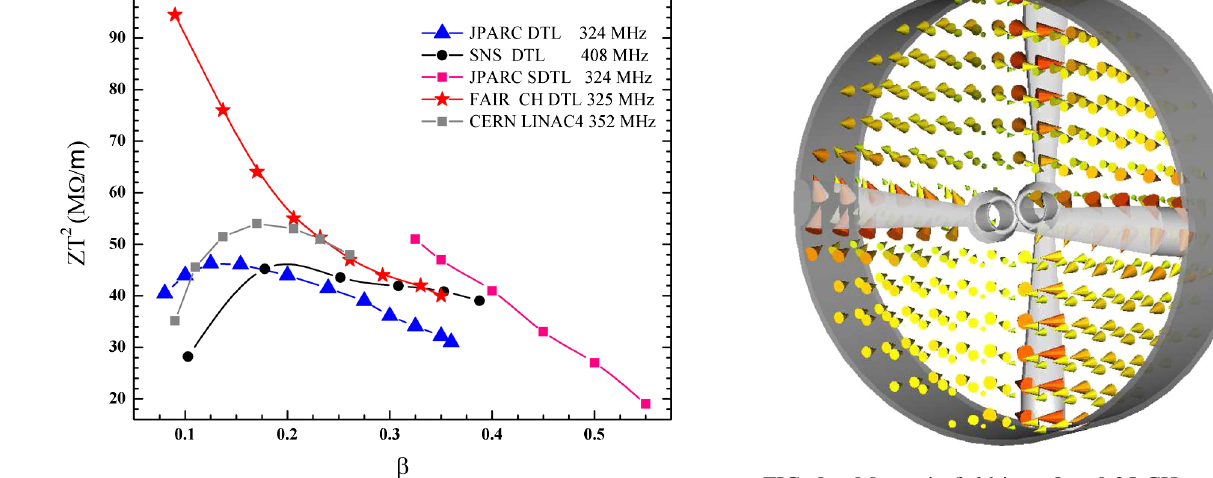
FIG. 8. Magnetic field in a (cid:2) ¼ 0 : 25 CH